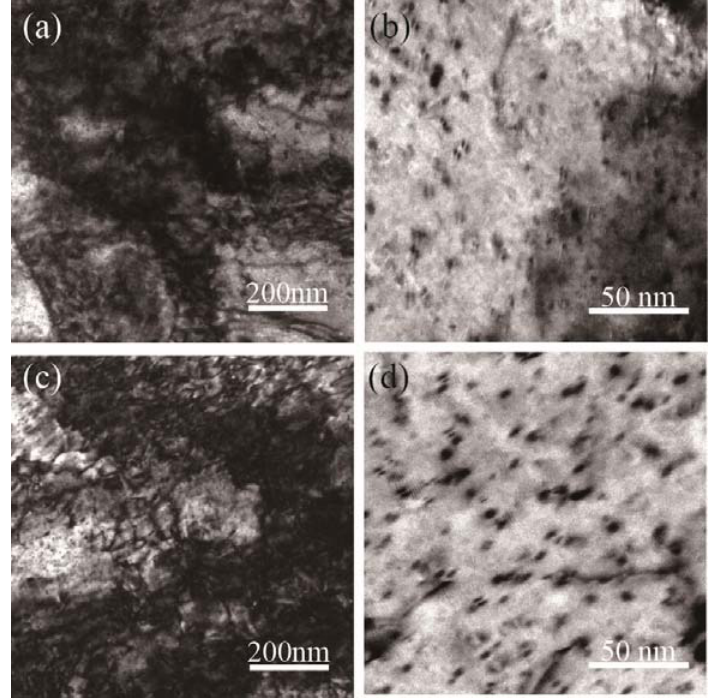
Figure 4. TEM images of the Cu–Cr–In alloy annealed at 450 °C for various times. ( a,b ) 60 min; ( c,d ) 240 min.